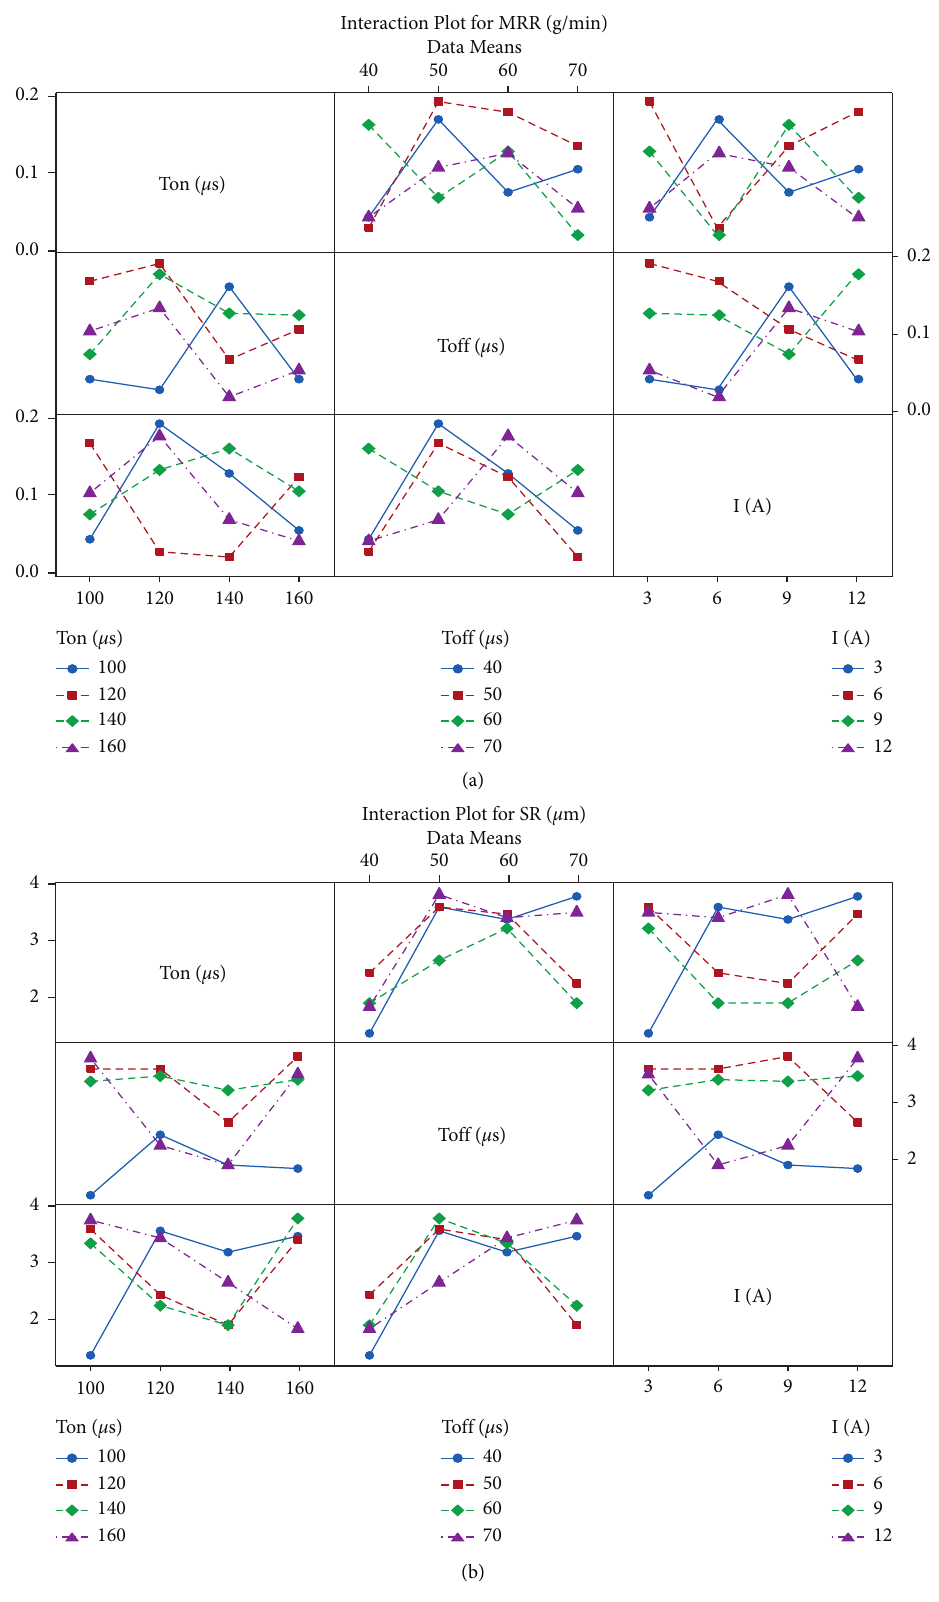
Figure 7: (a) Interaction plot for MRR. (b) Interaction plot for